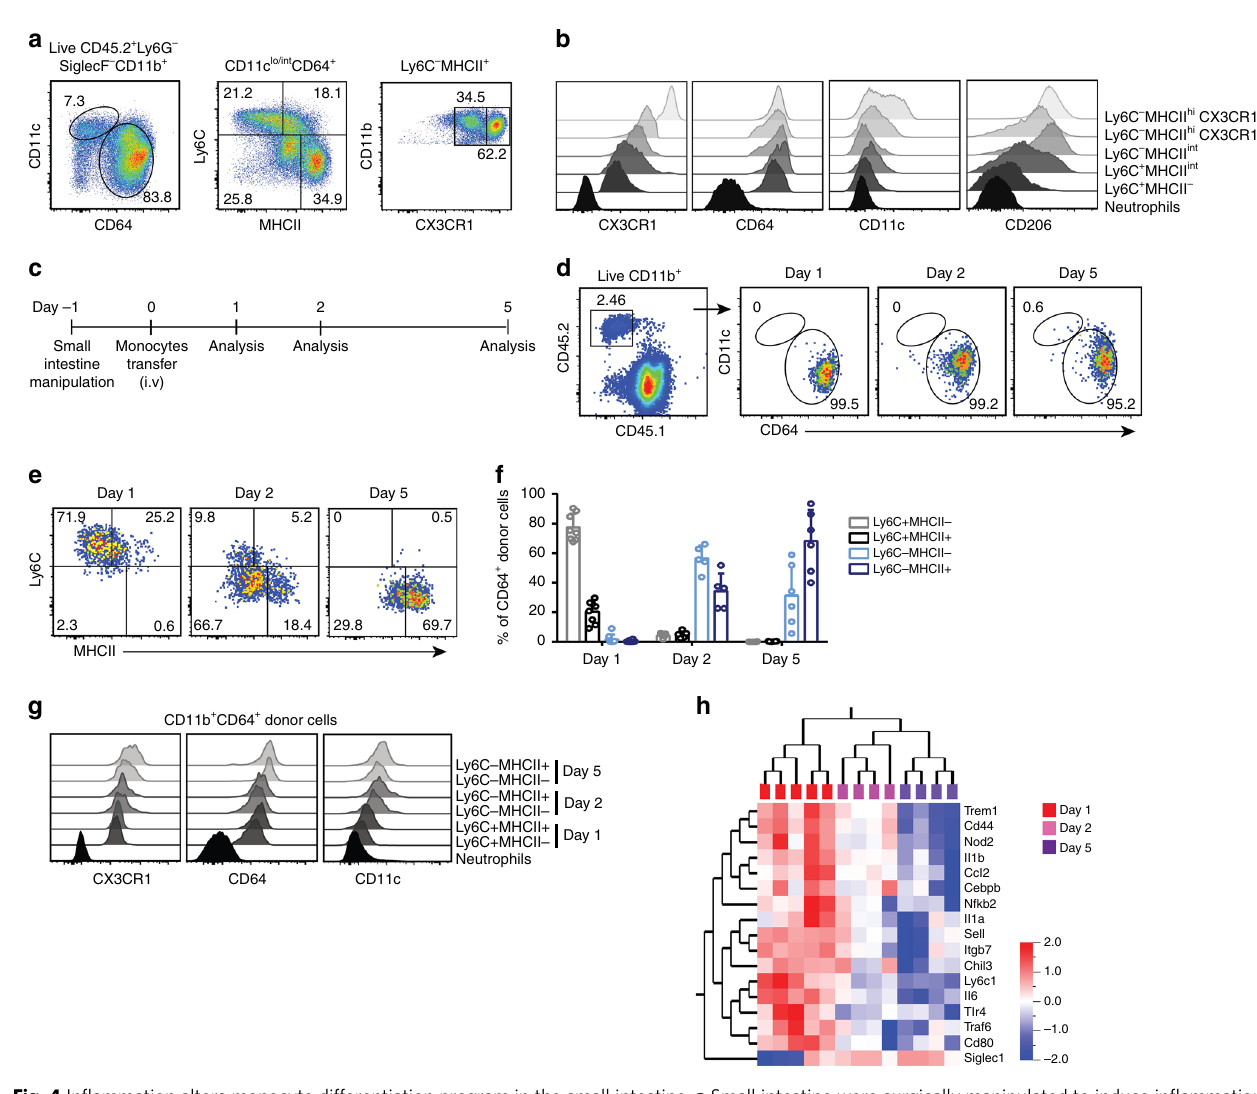
Fig. 4 In fl ammation alters monocyte differentiation program in the small intestine. a Small intestine were surgically manipulated to induce in fl ammation in the small intestine and 3 days after manipulation, intestinal Ly6G − SiglecF − CD11b + CD11c lo/int CD64 + leukocytes (MNP CD64 + cells) were divided into fi ve subpopulations based on expression of Ly6C, MHCII, and CX3CR1/GFP; namely Ly6C + MHCII − , Ly6C + MHCII int , Ly6C − MHCII int , Ly6C − MHCII hi CX3CR1 int and Ly6C − MHCII hi CX3CR1 hi . b Representative histograms demonstrating expression of CX3CR1, CD64, CD11c, and CD206 on subpopulations shown